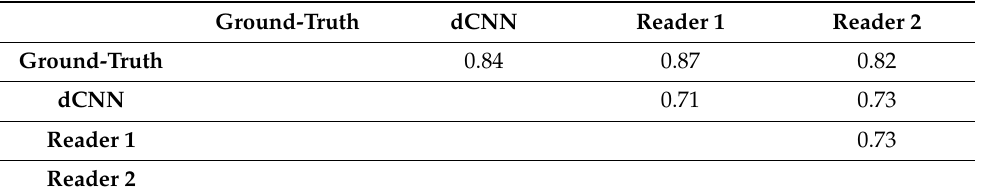
Table 5. Kappa values between each pair of both readers, “ground-truth” and dCNN Model 2 using a four-level density scale. According to Landis and Koch: 0.6 to 0.8 substantial and >0.8 almost perfect